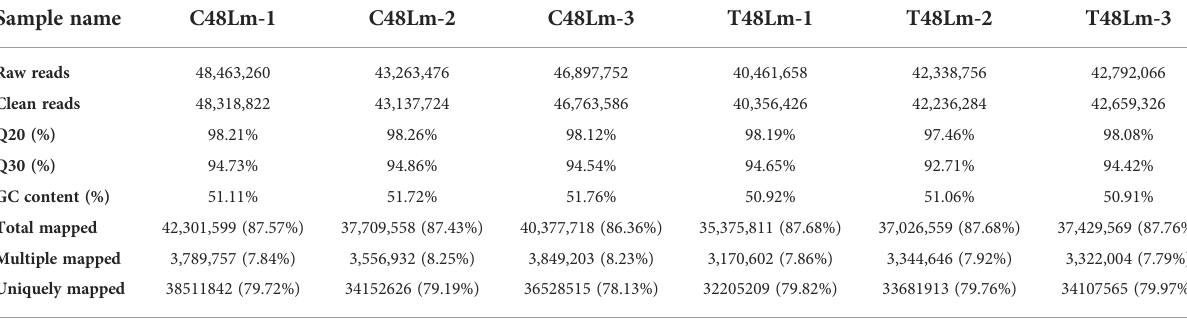
TABLE 1 Statistical results of comparison rate between reads and reference